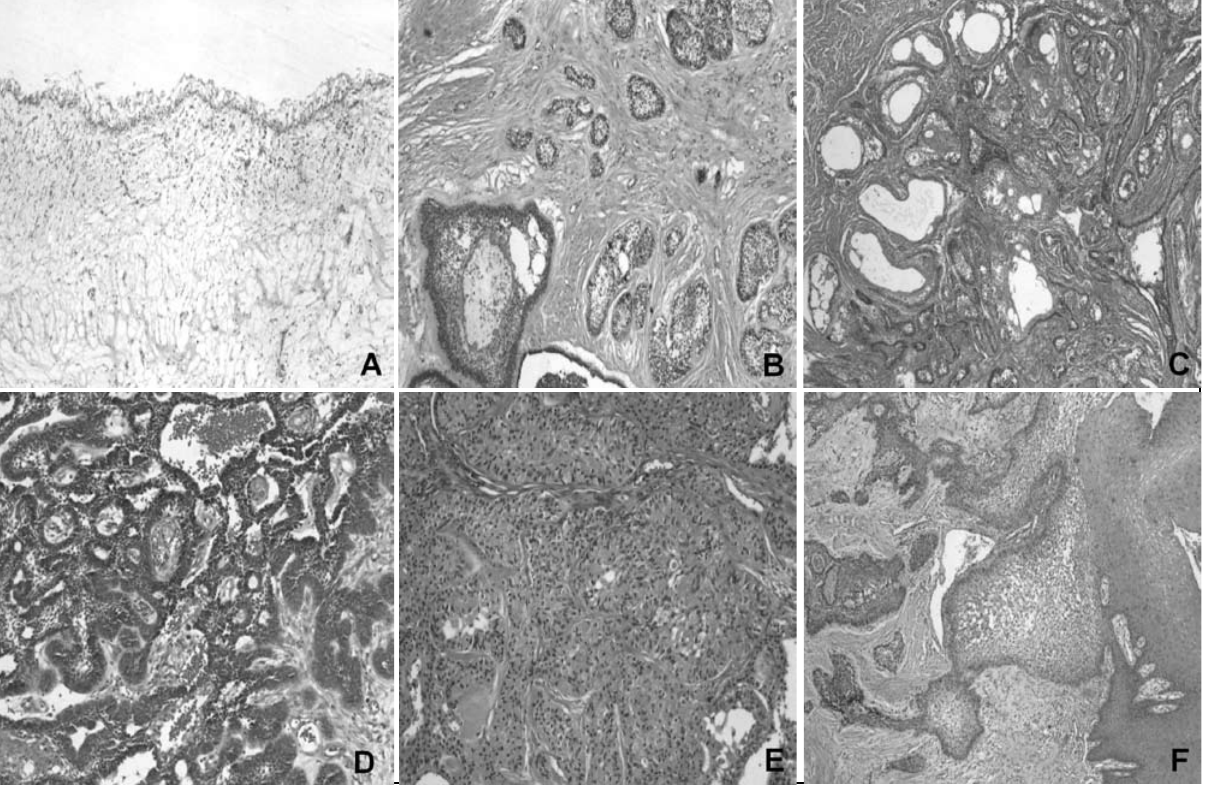
Figura 1 – Fotomicrografias dos padrões histopatológicos do ameloblastoma (HE, aumento inicial de 100x). A: unicístico; B: folicular; C: folicular exibindo áreas acantomatosas (hibrido); D: plexiforme; E: células granulares; F: periférico exibindo revestimento